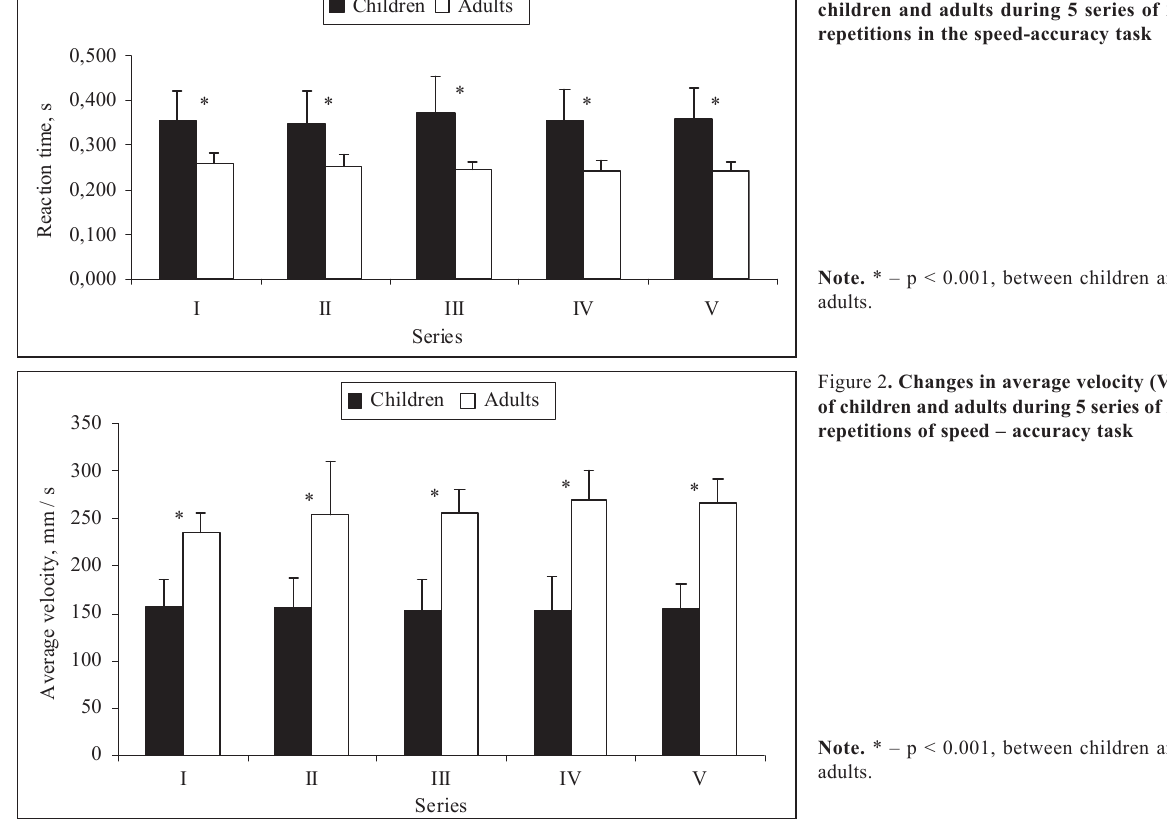
Figure 1. Changes in reaction time (RT) of children and adults during 5 series of 20 repetitions in the speed-accuracy task